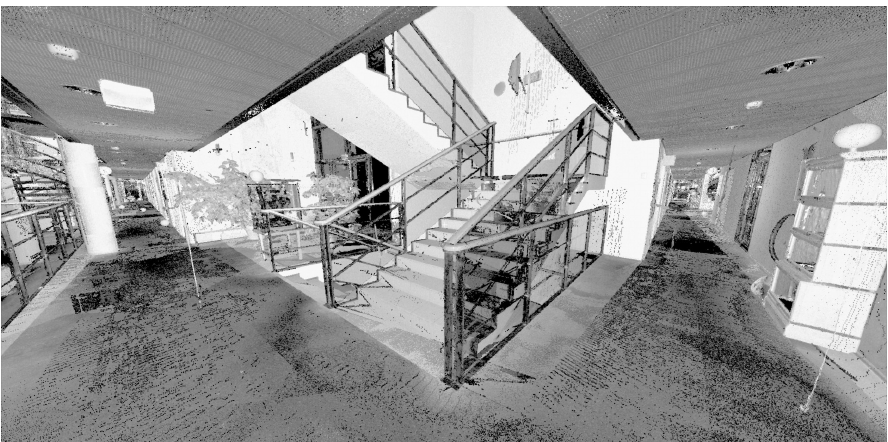
Figure 11. The hallway test site visualized from the turn point. The hallway continues to the left and to the right.